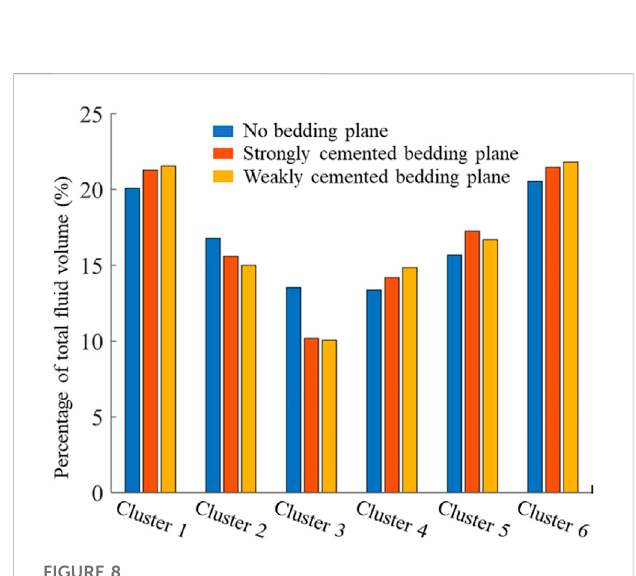
FIGURE 8 The total fl uid volume distribution of each cluster for three cases with different bedding development